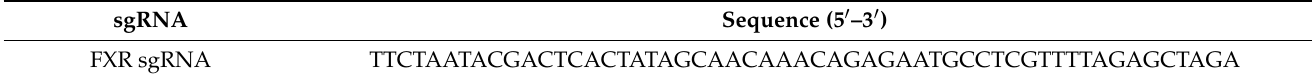
Table 1. sgRNA sequence used for CRISPR/Cas9 to generate Fxr ex5 ∆ animals.